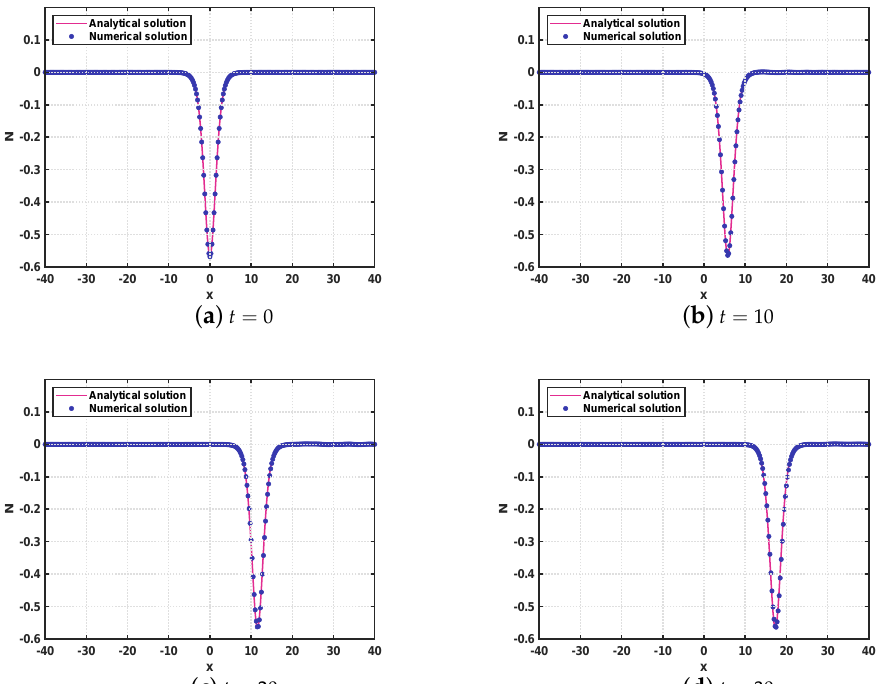
Figure 5. Comparison between numerical solution N f ( • ) and analytical solution N ( − ) with = 1 τ = τ C and h = 1 at different points in time for Case 2 of Example 2. 4 100 4